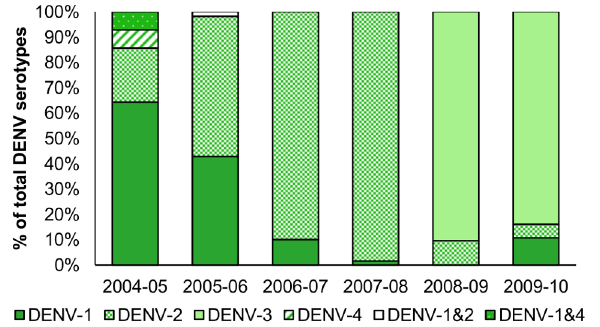
Figure 4. Distribution of DENV serotypes in dengue cases by study year. The percent of dengue cases infected by each DENV serotype, of the total infections with known serotype, are shown. Three hundred and thirty-one (94%) of the 351 dengue cases had serotype information available. Two cases of co-infection were detected: one DENV-1 & DENV-4 co-infection in 2004–05 and one DENV-1 & DENV-2 co-infection in 2005–06. The distribution of DENV serotypes in dengue cases from 2004–2005 to 2007–2008 has been previously reported [16].